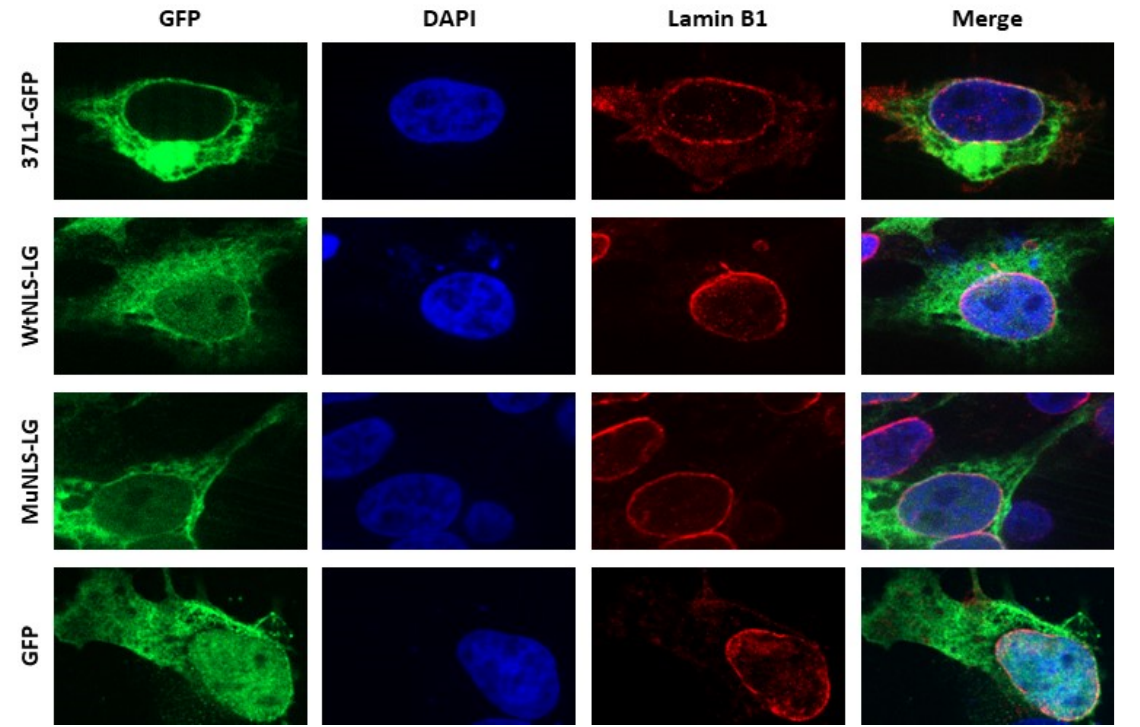
Figure 5. Amino terminus NLS is required for nuclear expression of GPR37L1 . hRPTCs were transfected with the indicated GPR37L1 constructs as in Figure 4A. Two days later, the expressions of wild-type or mutant GPR37L1 proteins were examined by immunofluorescence confocal microscopy at 600× magnification. The cells were also stained for lamin B1, a marker for nuclear inner membrane, and DAPI, a marker for nucleus. GPR37L1, green; nucleus, blue; lamin B1, red; plasma membrane, purple. White dots in the merge column indicate the expression of WtNLS-LG at the nuclear envelope.